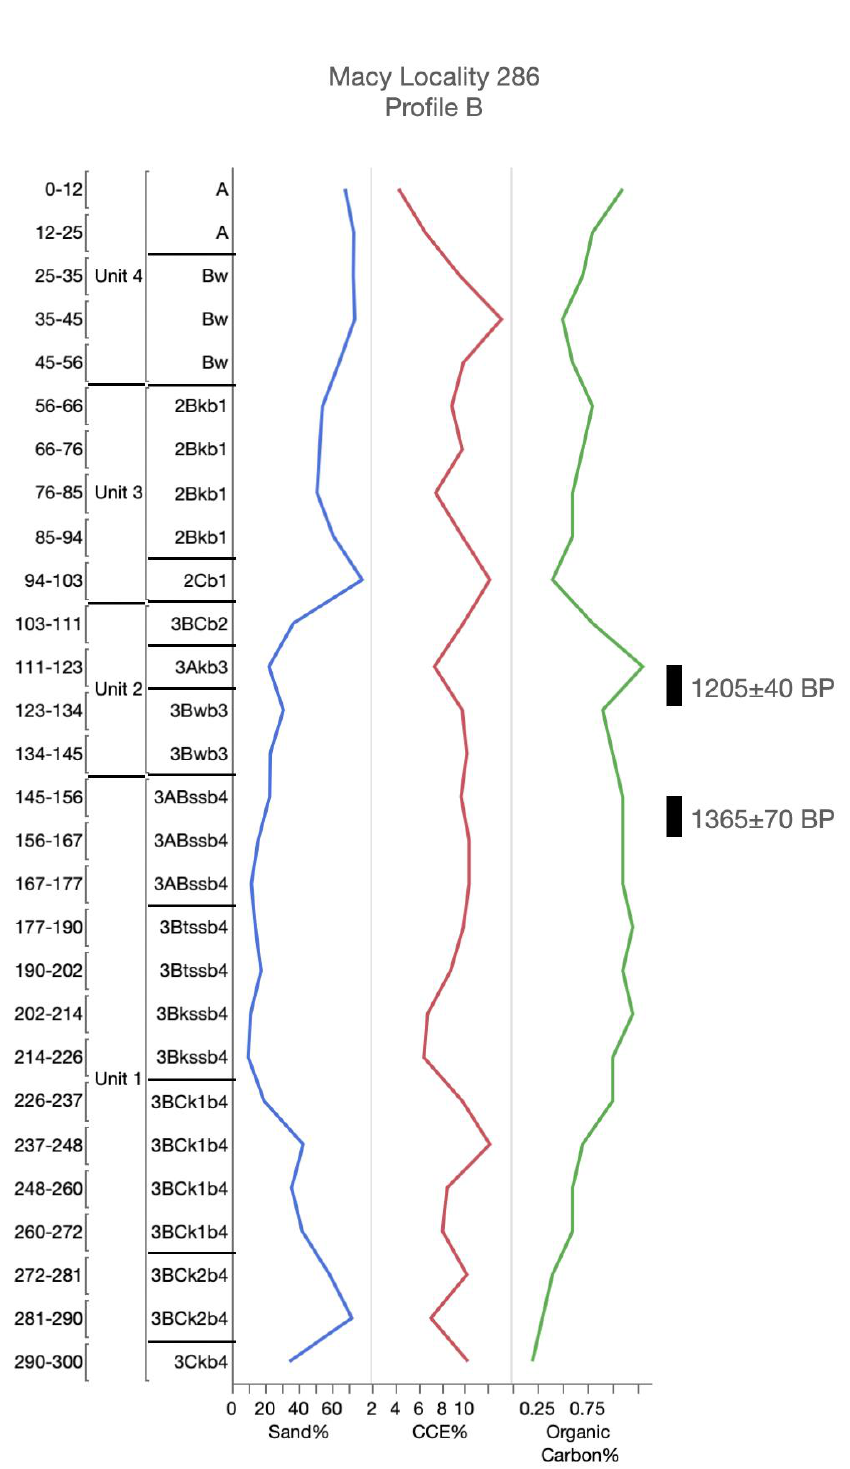
Figure A12. Accepted radiocarbon ages and soil and sediment analysis at Macy Locality 286, Profile B—Post research area, northwest, Texas. CCE = calcium carbonate equivalence.